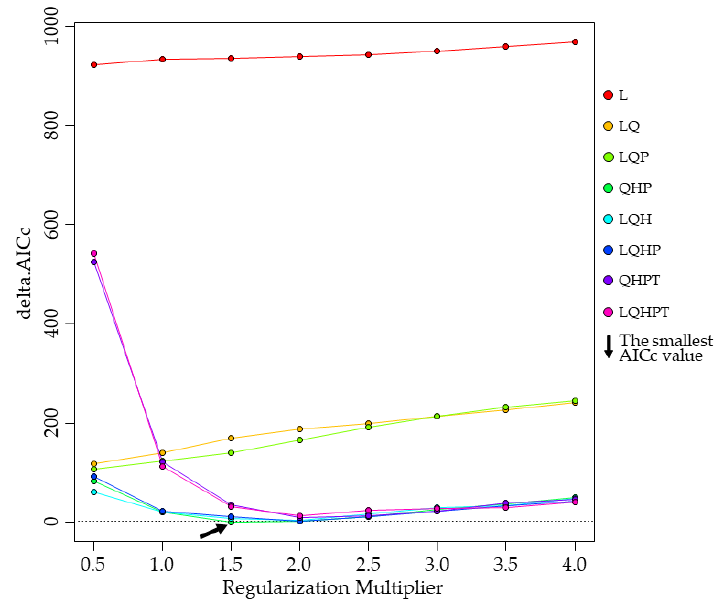
Figure 1. The regularization multiplier and feature classes of S. juvencus in the maximum entropy model.